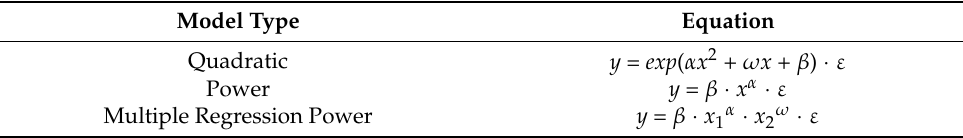
Table 1. Forms of the equations used in the different models of this study. Tree attributes are denoted as x , and constants are denoted as α , ω , and β in quadratic models. Constants are denoted as β and exponents are denoted as α and ω in power